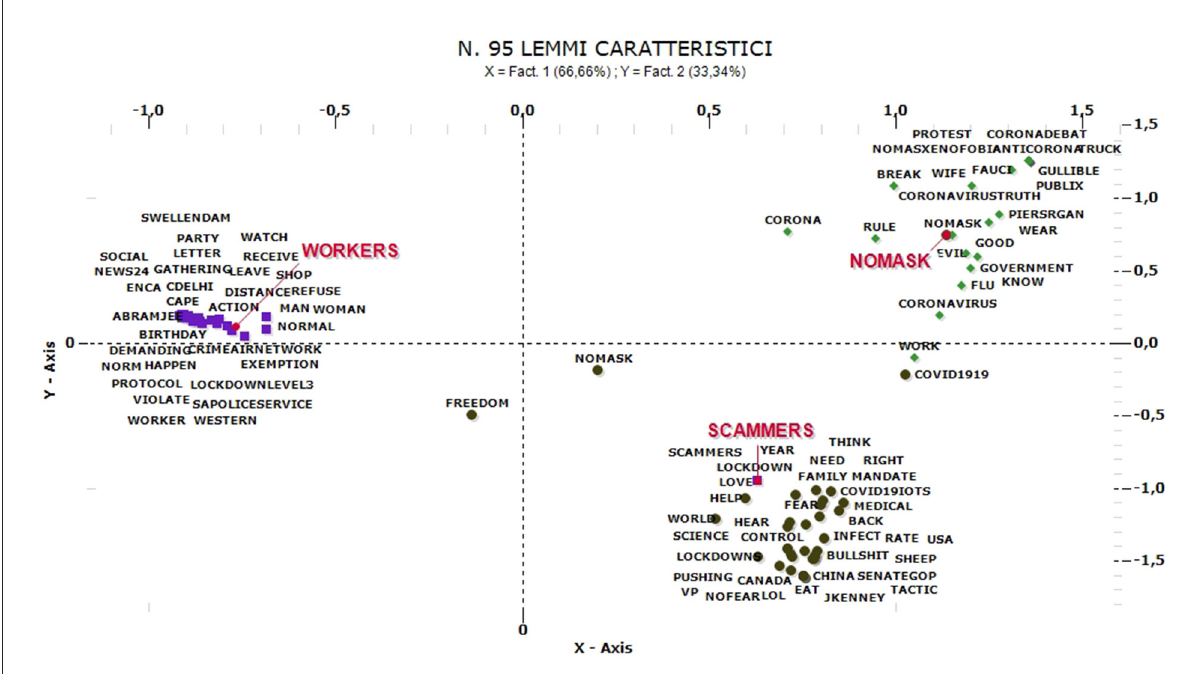
FIGURE8 ACM—“No-mask” comments in English (95 characteristic lemmas).